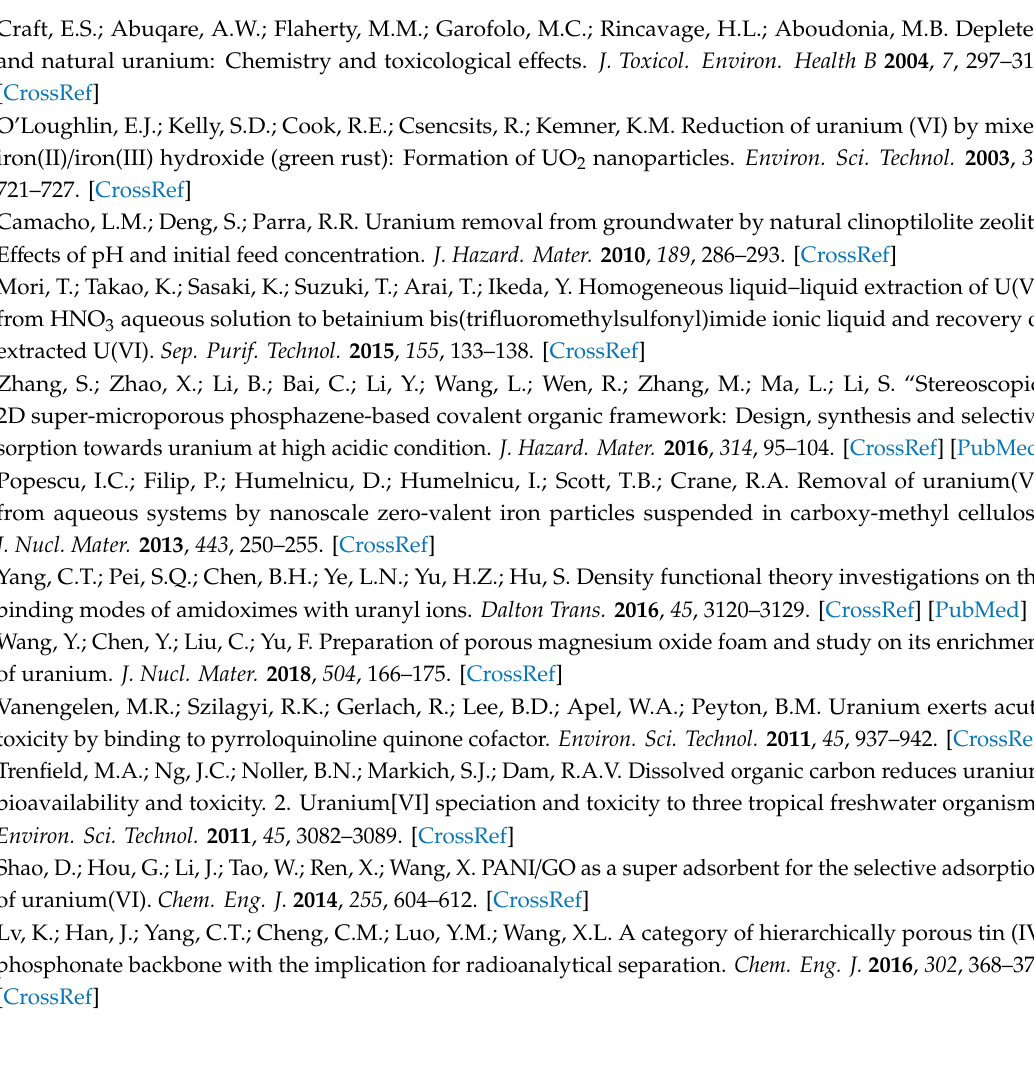
Figure S1: Schematic of the synthetic route of PVKAP, Figure S2: Original data for XPS